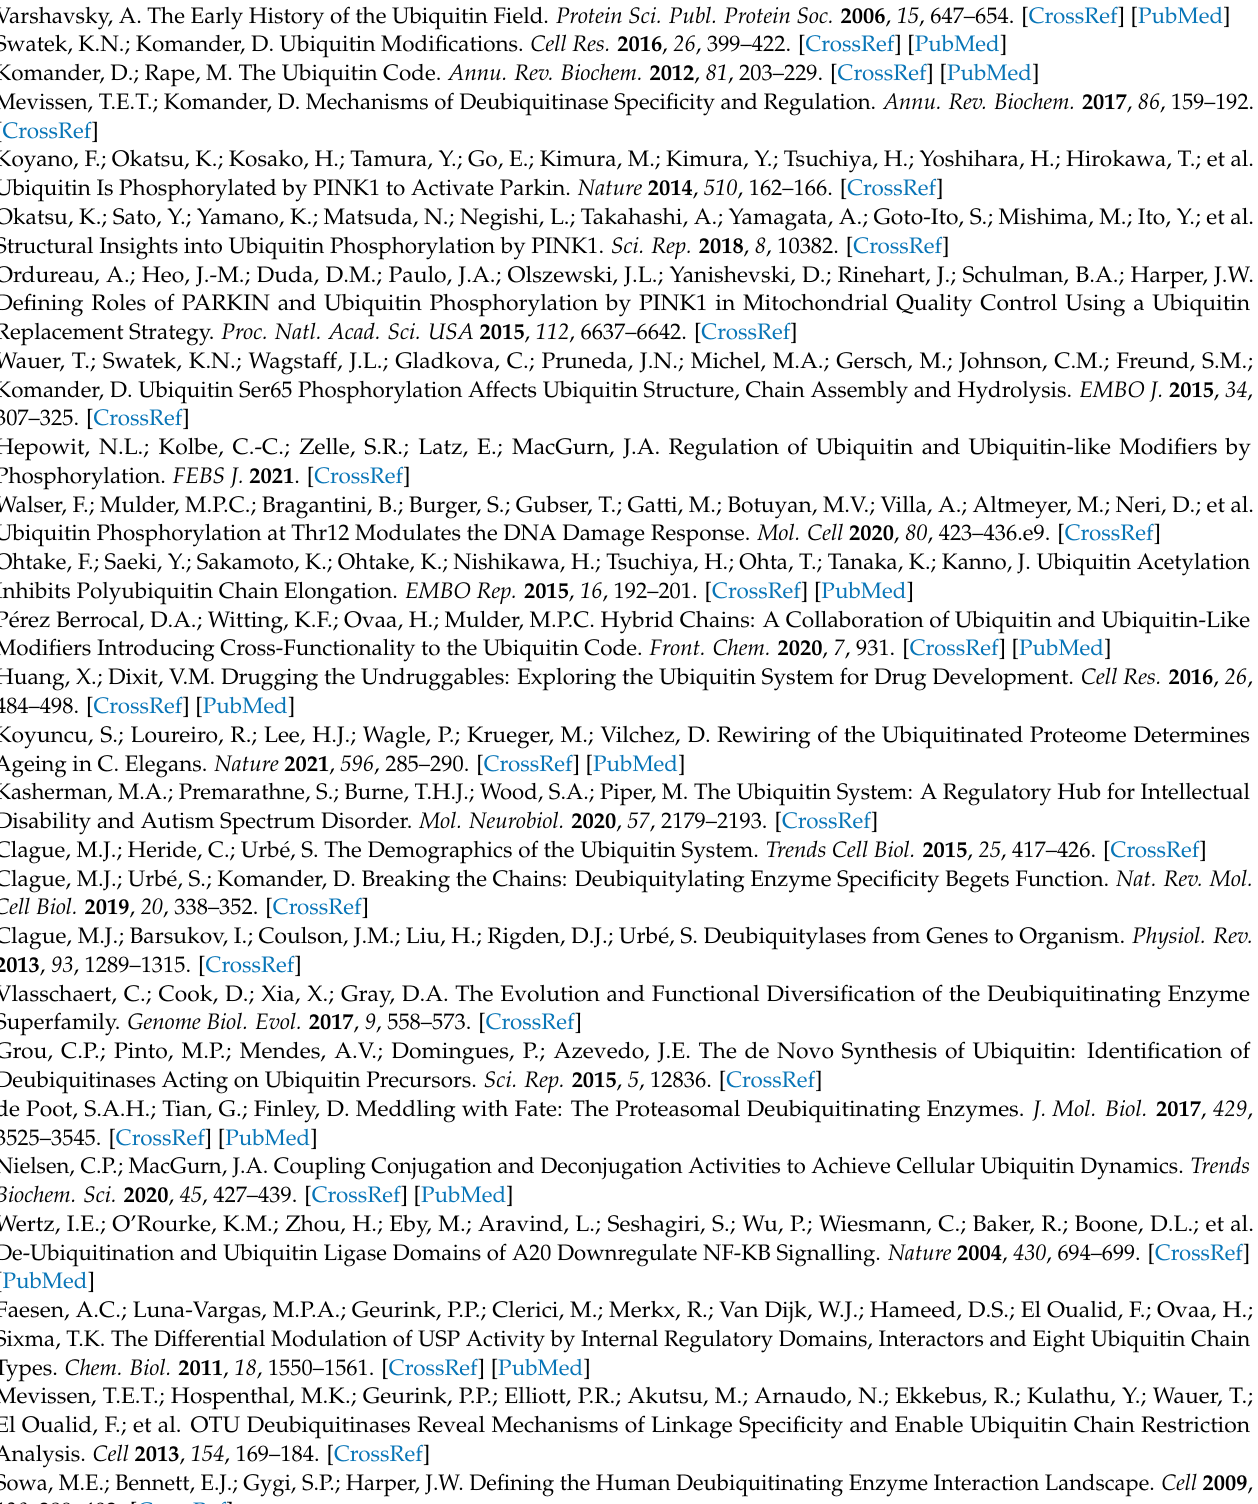
Ub C-terminal hydrolase; UIM, Ub-interacting motif; UPS, Ub proteasome system; USP, Ub-specific protease; VLP, virus-like particles; VME, vinyl methyl ester; XRD, X-ray diffraction; ZUFSP, zinc finger with the UFM1-specific peptidase domain